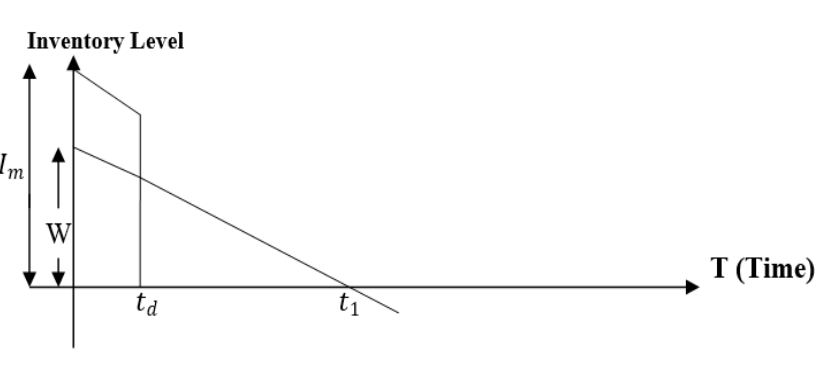
Figure 1. Graphical representation of the